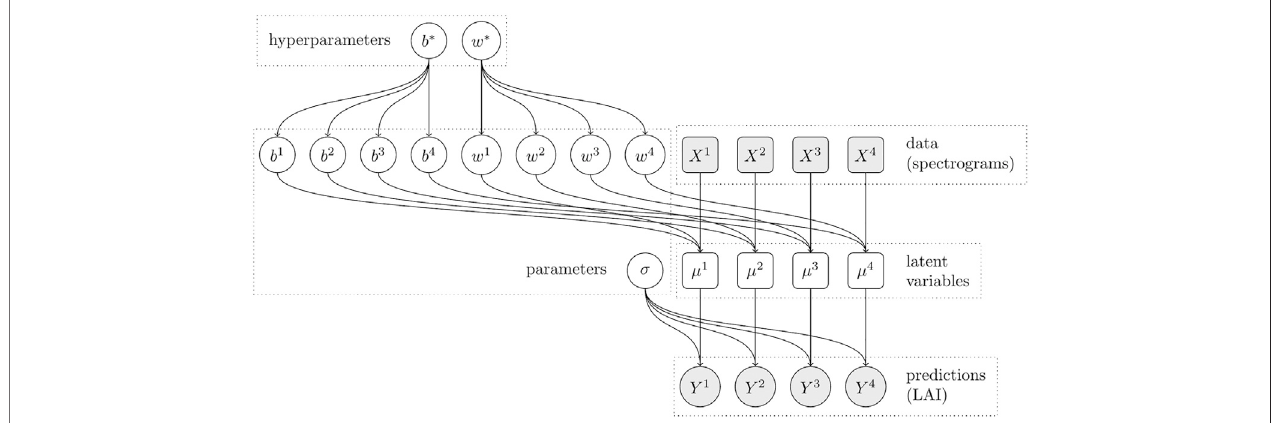
FIGURE 4 | Dependency graph of the hierarchical model with dataset-speci fi c bias and weight terms. The predictions for each dataset j now depend on an individual bias parameter b j and weight vector w j , which in turn depend on the shared bias parameter b * and the shared weight vector w *,